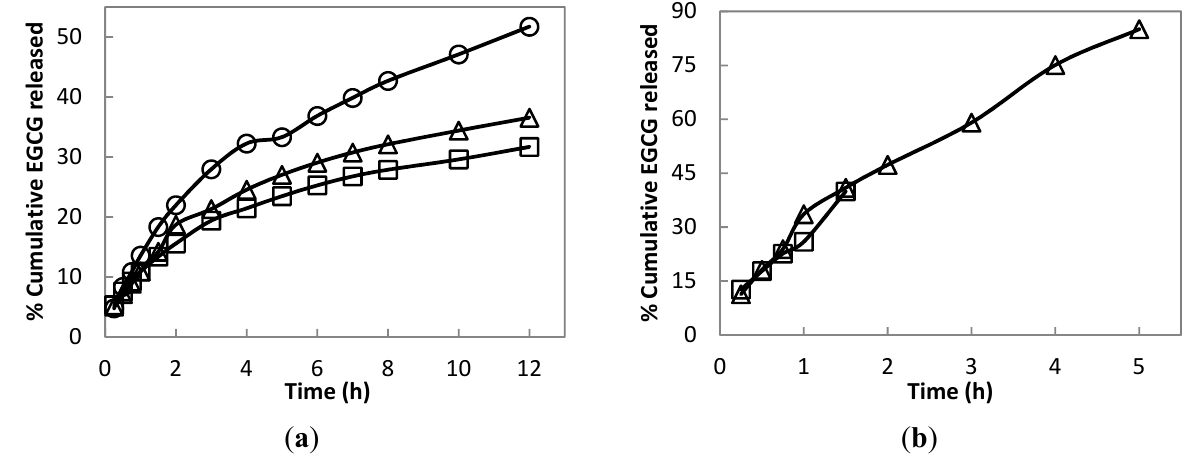
crosslinked hydrogel in PBS of different pH values (- ○ -, pH 1.2; - □ -, pH 6.8; - ∆ -, pH 7.4)